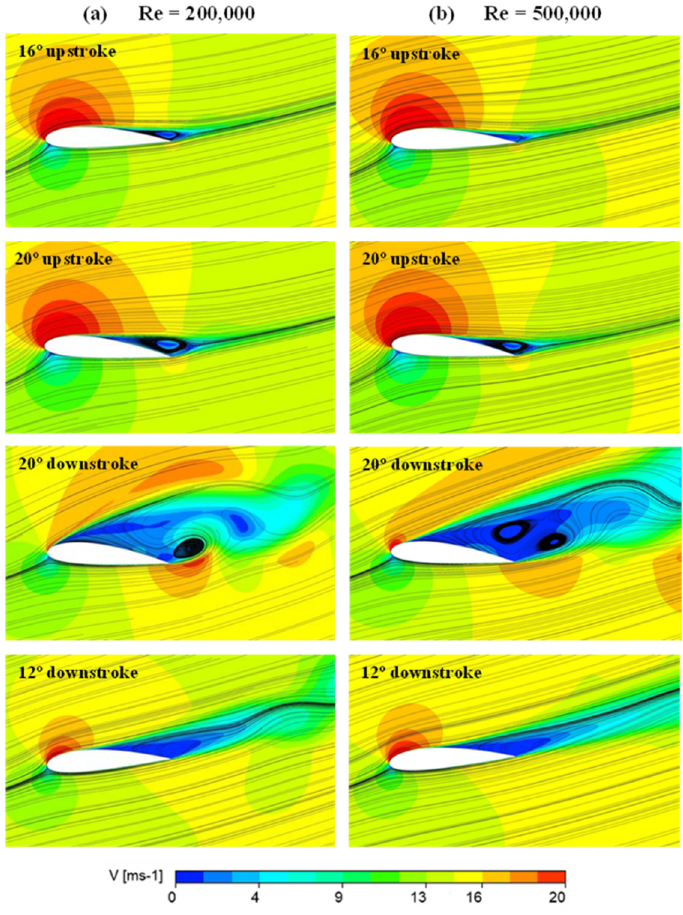
Figure 6. Velocity contours and streamlines at different α angles for ( a ) Re = 2 × 10 5 and ( b ) Re = 5 × 10 5 .